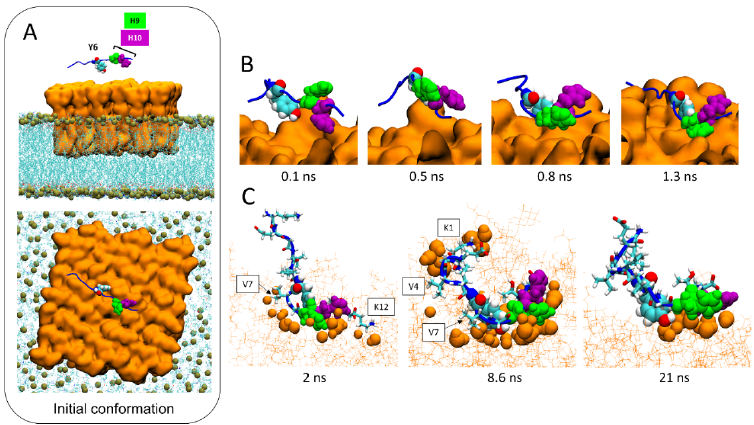
solvent molecules.